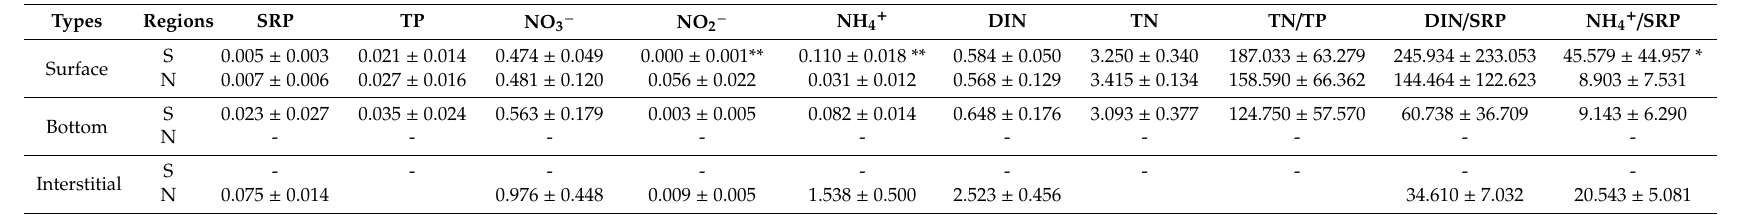
Table 1a. Di ff erences in nutrient concentrations among the sampling stations in the southern (S) and northern (N) regions.